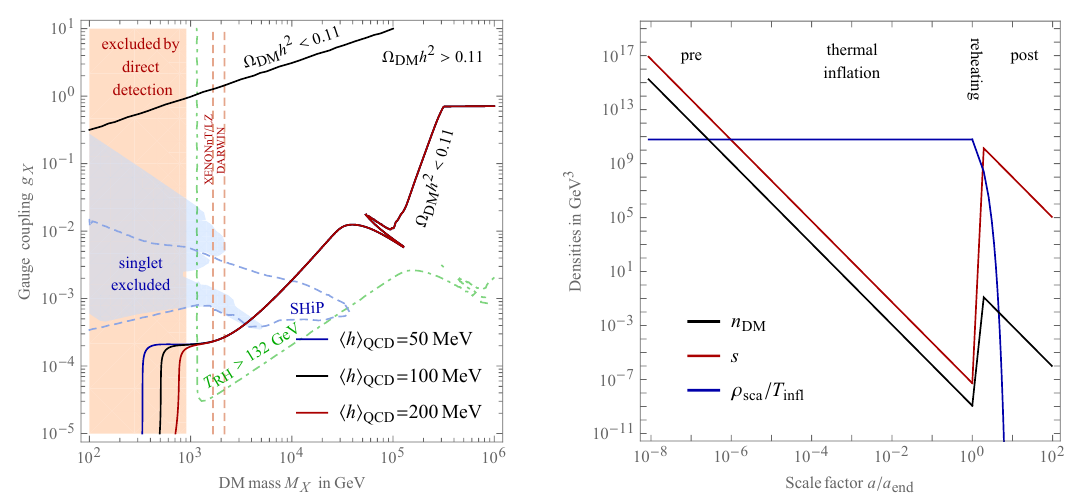
Figure 3 . Left: The observed DM abundance is reproduced along the solid curves, computed for di(cid:11)erent values of the uncertain QCD factor h h i QCD . The region shaded in orange (blue) is excluded by direct DM searches (collider searches for the singlet s ). Dashed curves show future detection prospects. Right: sample evolution of the DM density, of entropy, of the scalar